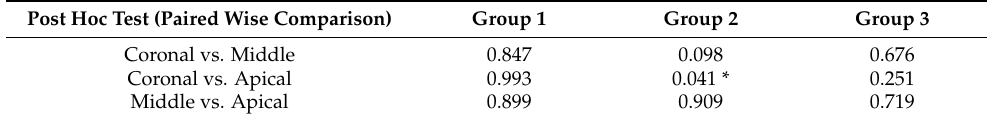
Table 2. The multiple comparisons between the three groups (Group 1: sodium hypochlorite and saline; Group 2: Arnica montana ; and Group 3: chlorhexidine).